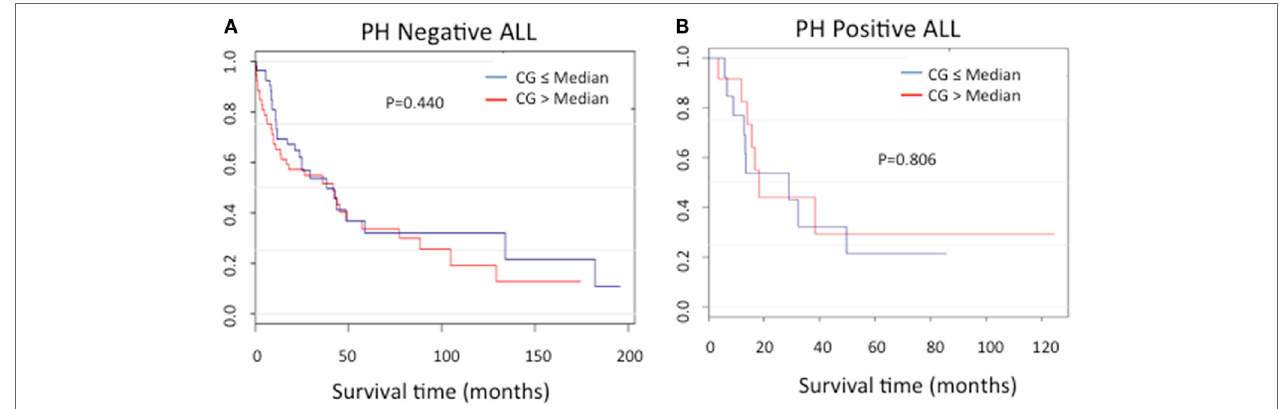
FigUre 6 | Cathepsin G (CG) protein expression and ALL survival. Kaplan–Meier curves show no significant differences in survival in patients with (a) Ph-negative ( n = 104; P = 0.44) or (B) Ph-positive ( n = 25; P = 0.806) ALL according to CG